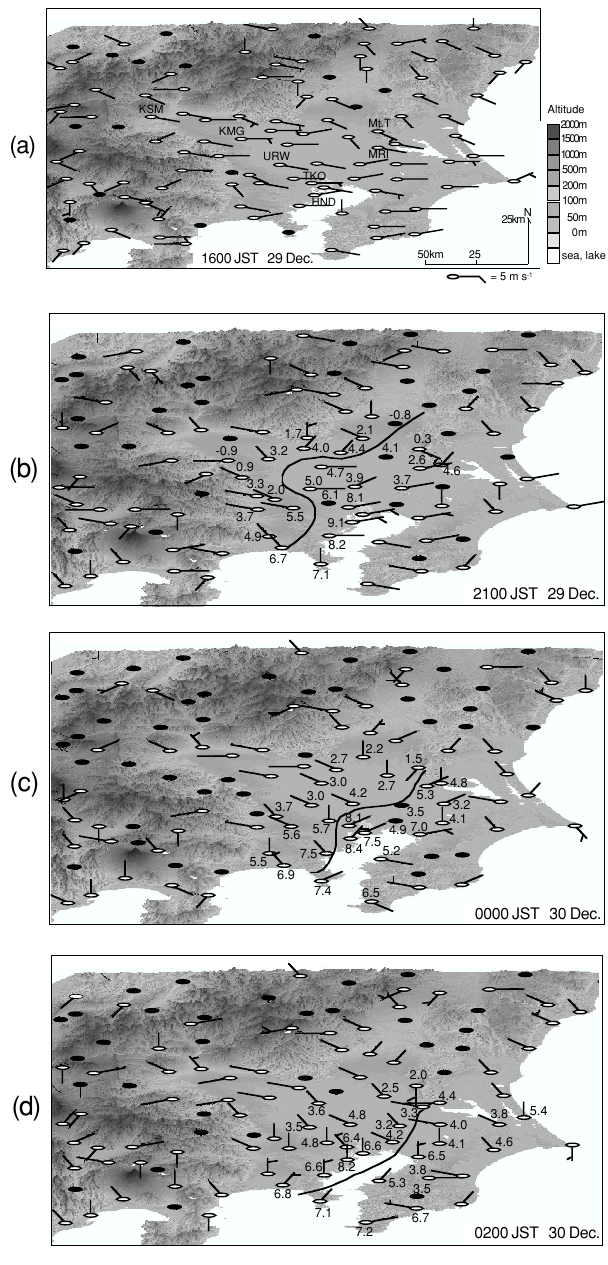
Fig. 4. Surface wind and temperature ( ◦ C) observed at ( a ) 16:00 JST on 29 December, ( b ) 21:00 JST on 29 December, ( c ) 00:00 JST on 30 December and ( d ) 02:00 JST on 30 December. A full wind barb is 5 m s − 1 , and black oval indicates wind speed less than 0.5m s − 1 . The gray scale represents geographic height. Station names are abbreviated as follows: Kamisatomi, KSM; Ku- magaya, KMG; Urawa, URW; Tokyo, TKO; Haneda, HND; and Mt. Tsukuba, Mt.T. Lines in (b) through (d) indicate the location of the gravity current